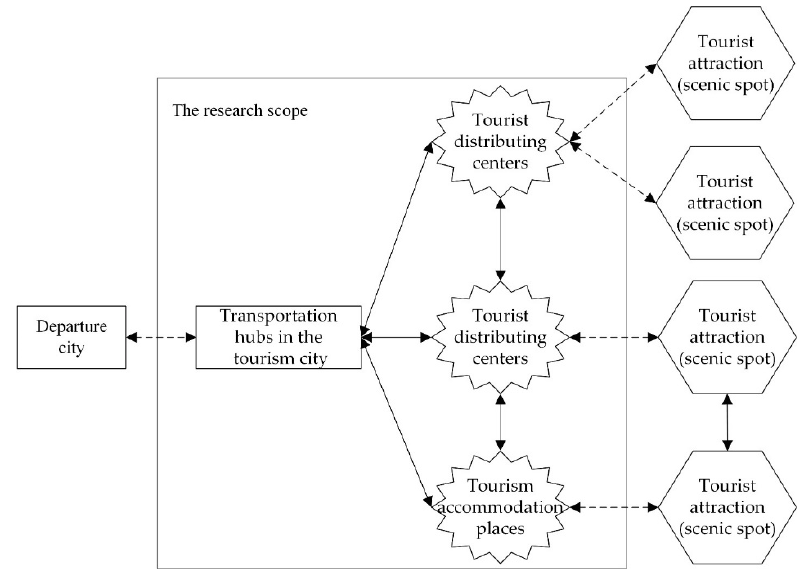
Figure 1. Tourism activity